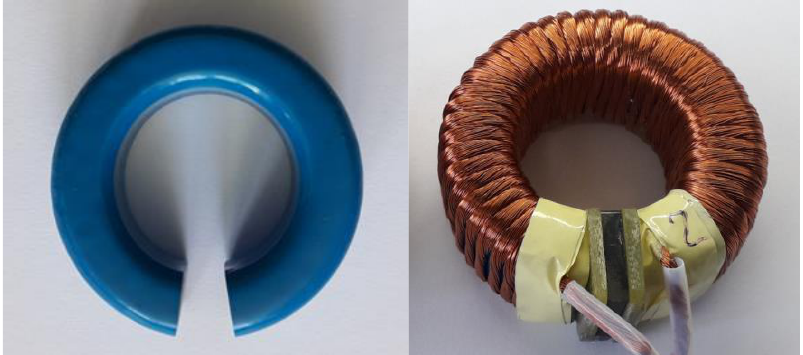
Figure 10. Alternative of the toroidal inductor with air gap given by product type ( left ) and modi- fication by shortening airgap by ferrite material inserted within air gap ( right ).